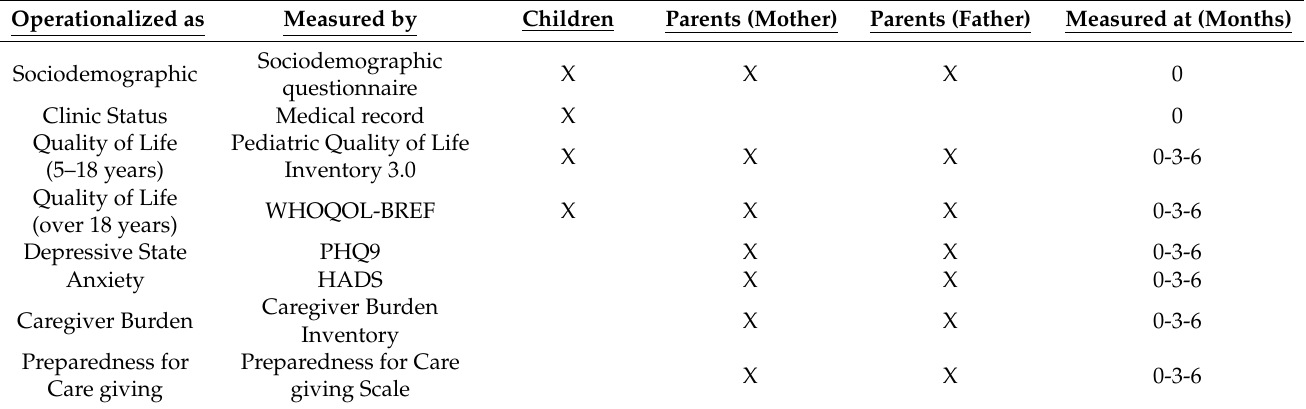
Table 1. Variables and Instruments that Will Be Used for Data Collection: Individual